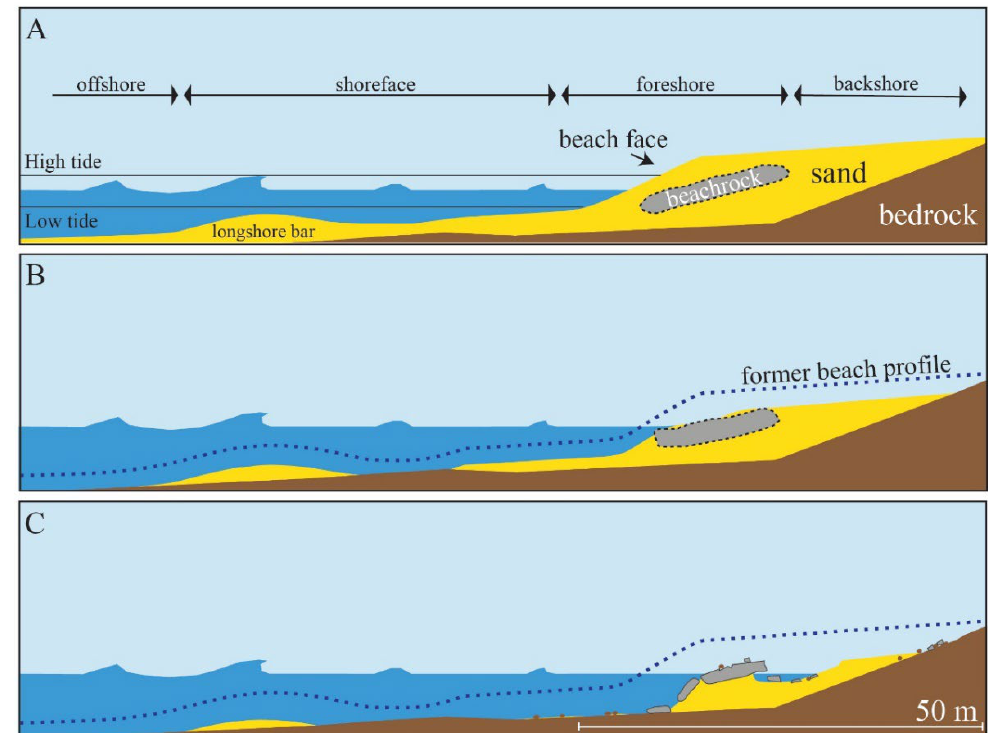
Figure 1. Schematic lateral cross section of a beach depicting stages in BR outcrop evolution inside an unconsolidated sediment lens: ( A ) initial stage: formation of solid sub-surface, BR accumulation within the shore face; ( B ) intermediate stage: erosion of sandy beach face and exposure of BR (the initial beach section is shown dotted); ( C ) progressive stage: extensive exposure of BR outcrop and development of erosion features.